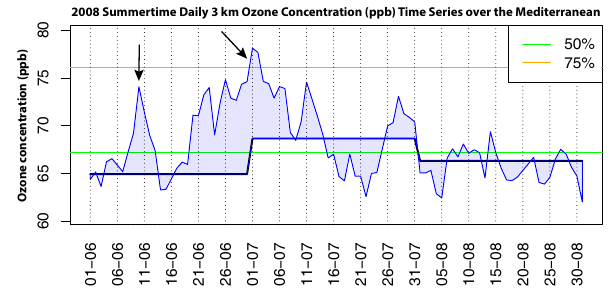
Figure 9. 2008 summertime day-to-day mean 3km ozone concentrations(ppb) time series measured by IASI (thin blue curve) over the Mediterranean (IASI morning overpasses). Only the ob- servations over the sea are considered in the averages. 2007–2012 3km ozone concentration monthly means are plotted as the thick dark blue curve. Horizontal coloured lines represent the 2007–2012 summertime (JJA) 3km ozone quantiles for the data set of individ- ual